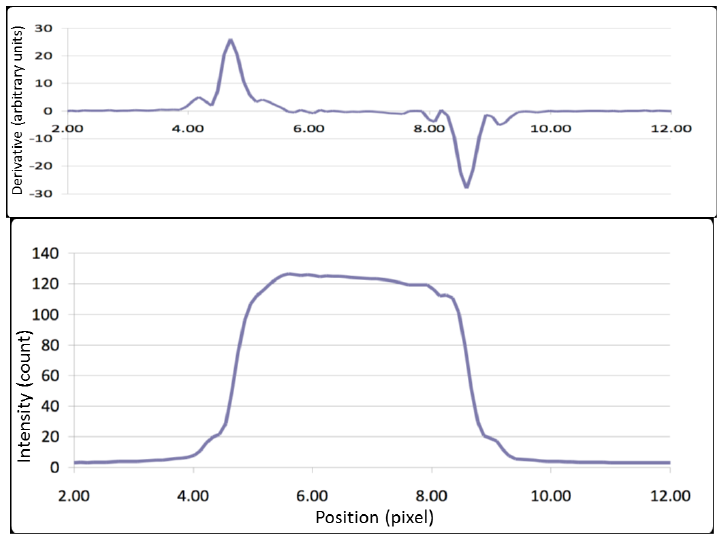
Figure 6. The bottom curve shows a cross section across one of the slitlet images produced by the microslicer (Figure 5). The sharpness of the edges is used to determine the image quality of the microslice system. The upper curve shows the derivative of this profile; the width of the two peaks corresponds closely to the spatial Point Spread Function (PSF) of the system (76% In Slit Energy) and is less than 1 pixel on the spectrograph